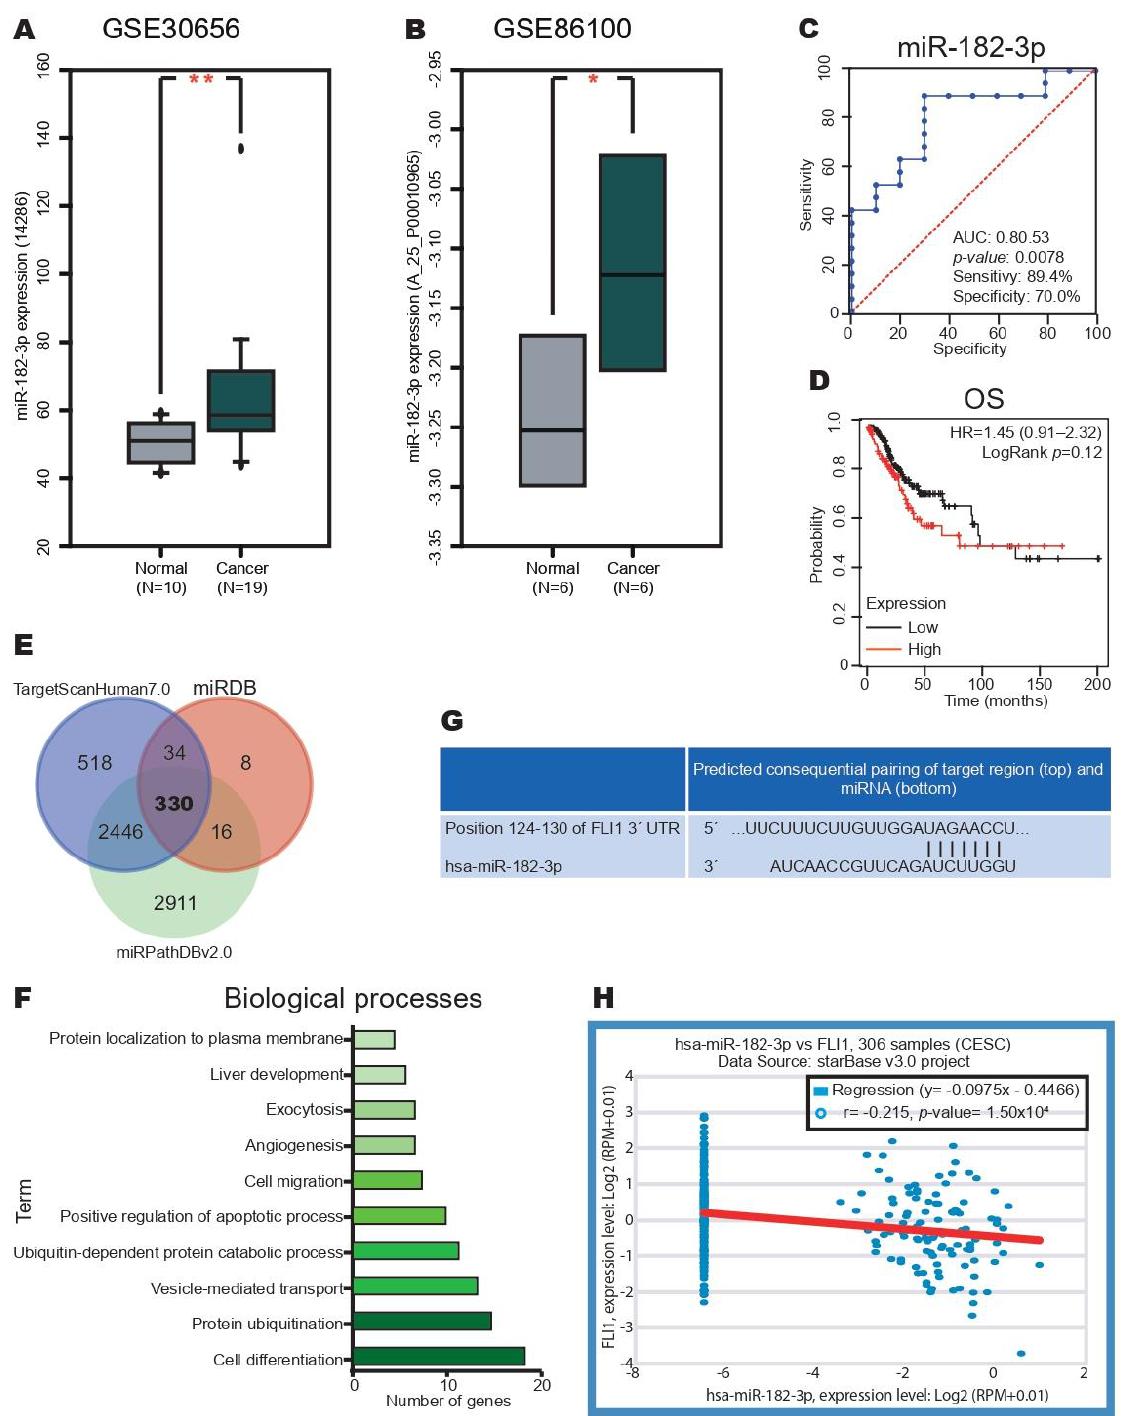
Figure 1. miR-182-3p expression increases in cervical cancer. ( A ) miR-182-3p expression in CC and normal tissue samples from the GSE30656 dataset. ( B ) miR-182-3p expression in CC and normal tissue samples from the GSE86100 dataset. ( C ) Diagnostic value of miR-182-3p. ( D ) Kaplan–Meier curves of OS according to the miR-182-3p expression in CC samples of patients with CC from the TCGA dataset. ( E ) FLI1 mRNA is a potential target in the miR-182-3p, miRTargetLink Human and miRDB databases. ( G ) Pairing between the target region and miRNA from the TargetScanHuman7.0 database. ( F ) Biological processes of these 330 target mRNAs of miR-182-3p. ( H ) Correlation between FLI-1 and miR-182-3p expression in patients with CC from the TCGA dataset. Median cut-off. * p -value < 0.05 and ** p -value < 0.01.